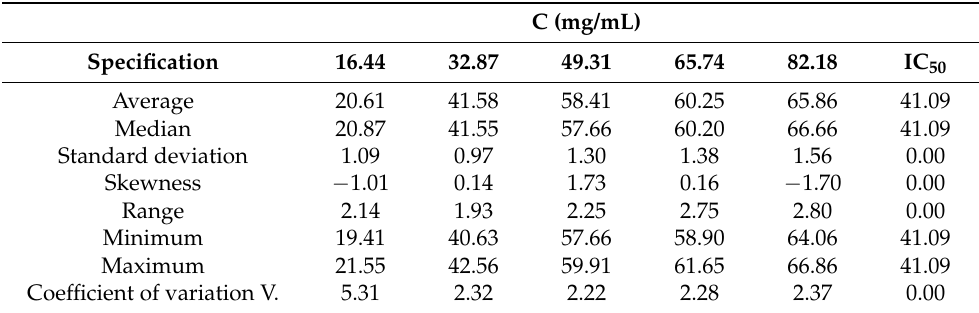
Table 8. Descriptive statistics of DPPH radical scavenging activity of the essential oil of Thymus algeriensis (overground part).